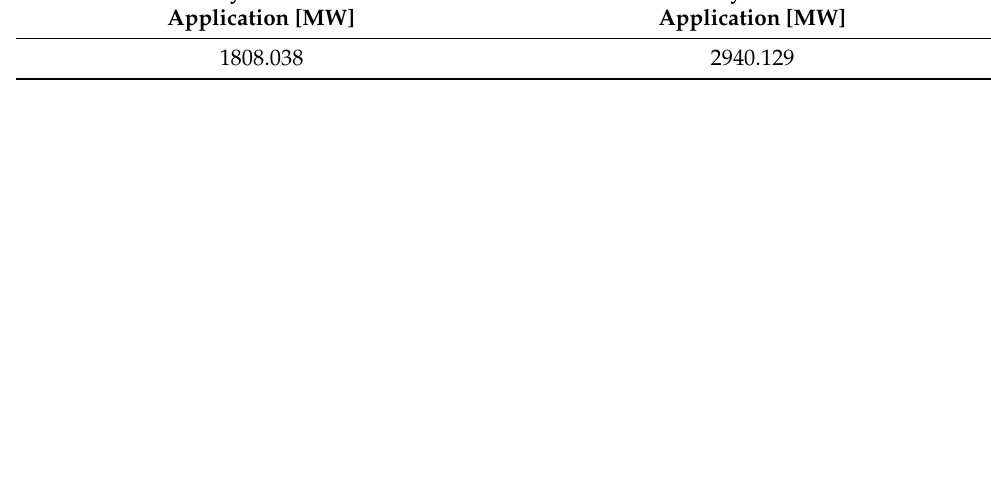
Table 3. Comparison of energy used by inverter before and after BL method application for 200